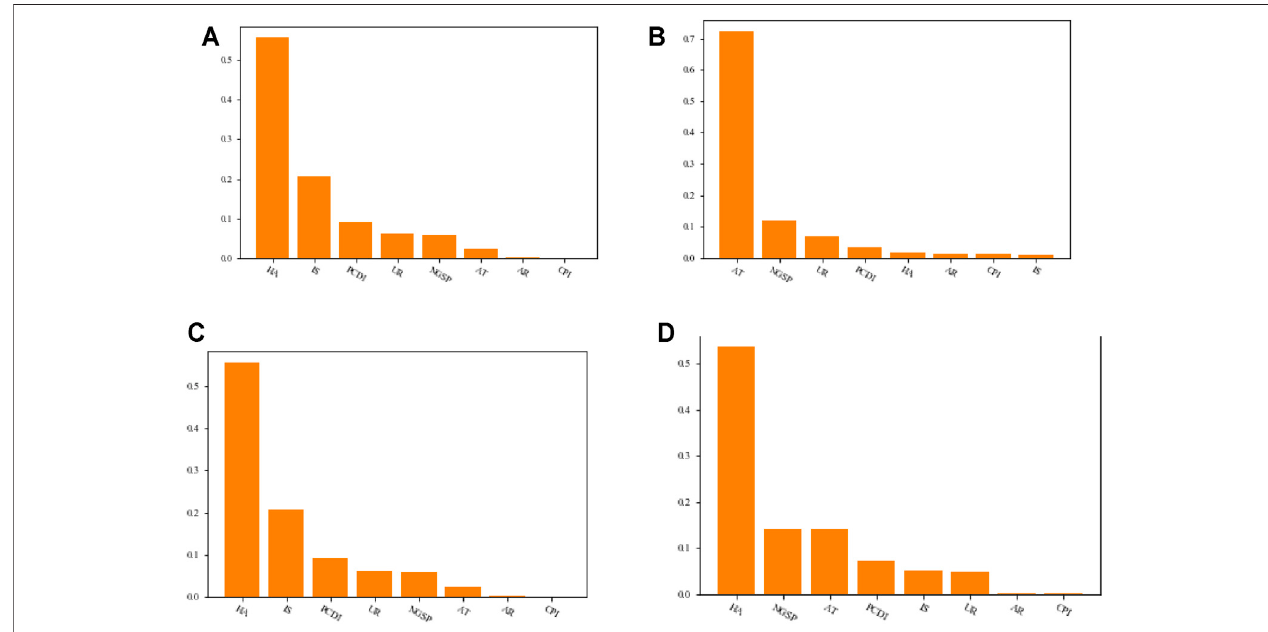
FIGURE 6 | Ranking the importance of non-linear predictor variables of electricity consumption in urban households across the country.